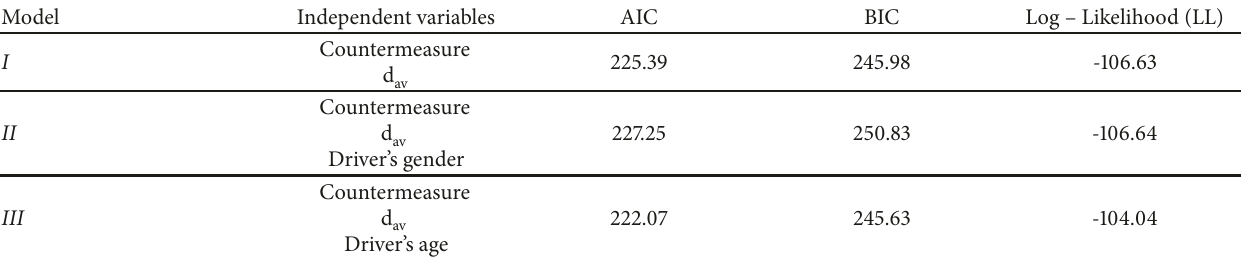
Table 4: Summary of information criteria comparison of three Weibull regression models.